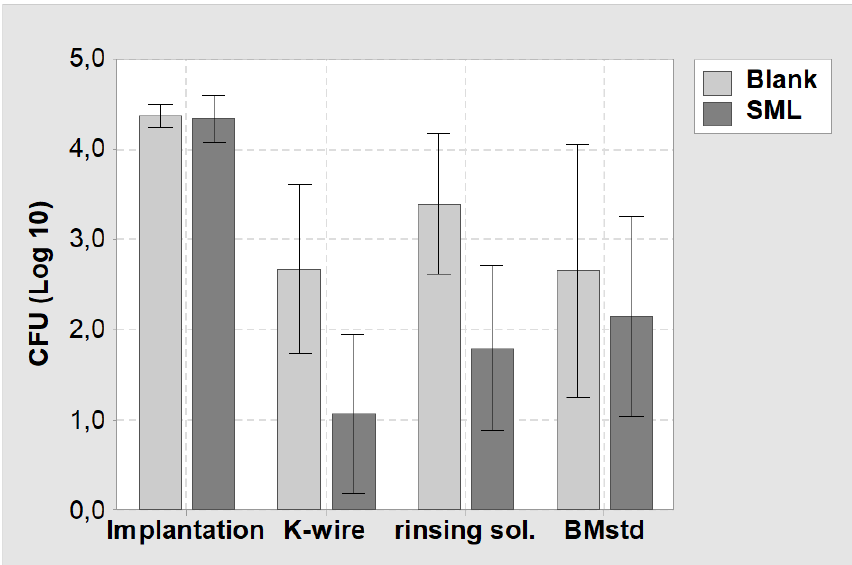
Figure 7. Mean values and 95% confidence interval of the CFU count of the in vivo study. (Implantation) = CFU count at implantation on the K-wire surface. (K-wire) = Bacterial suspension derived from the K-wire surface at explantation. (rinsing sol.) = Bacterial suspension derived from rising the K-wire surface to remove attached tissue. (BMstd) = Bacterial suspension derived from the bone marrow (normalized to 1 gram). Light grey = Blank items, dark grey = SML items.